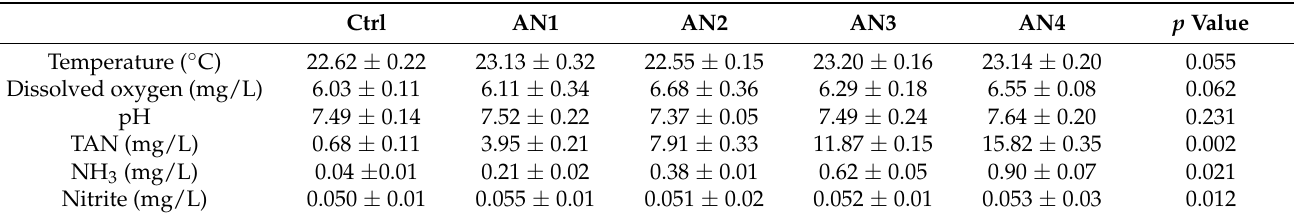
Table 1. Water condition during the